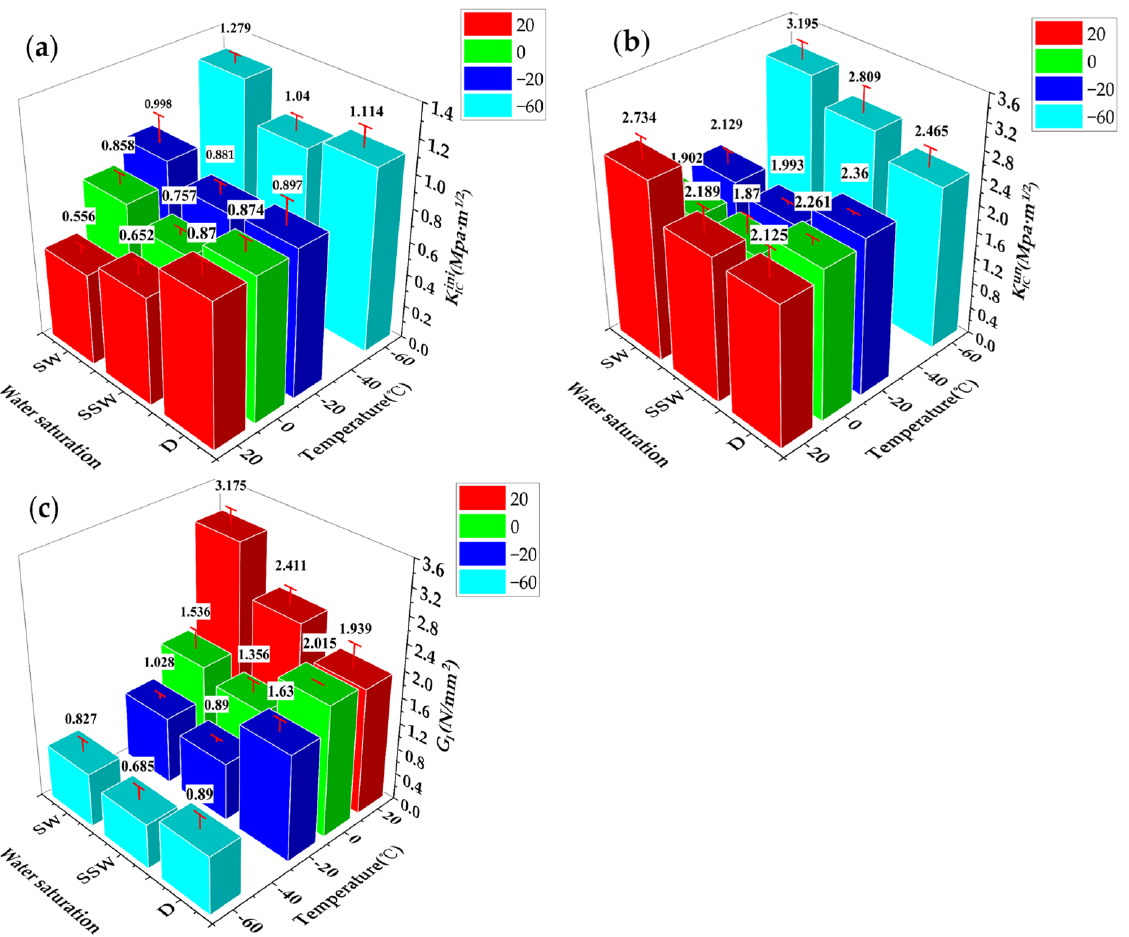
Figure 11. Changes in ( a ) K ICini , ( b ) K ICun , and ( c ) G temperature.